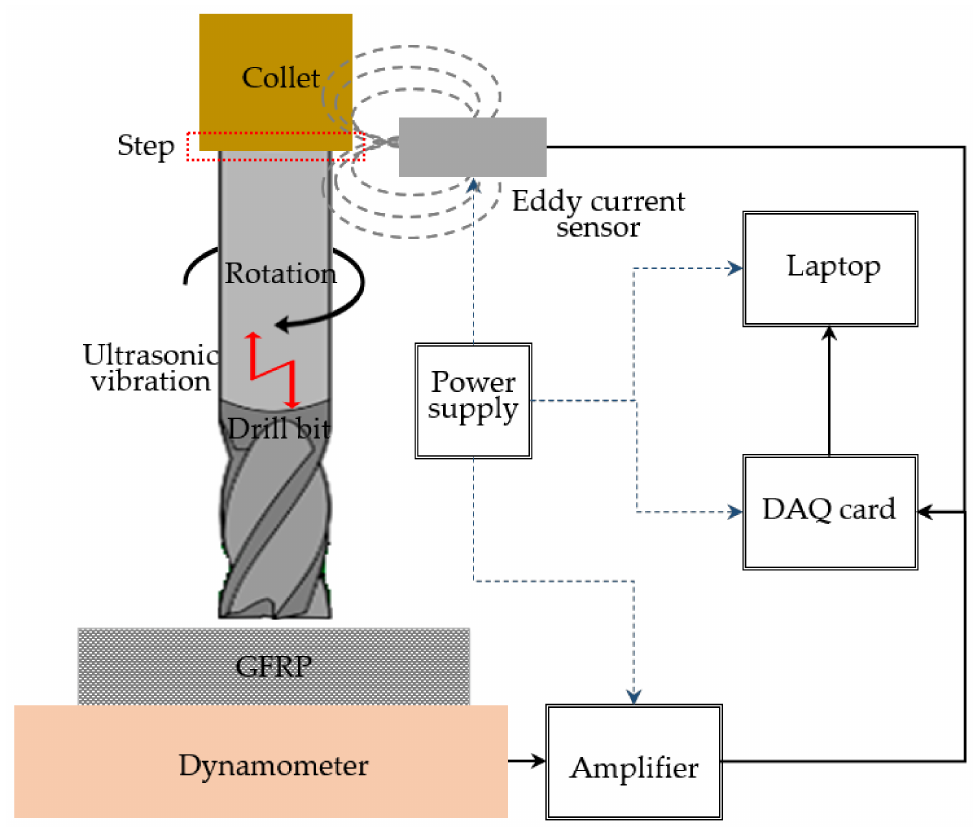
Figure 1. Schematic illustration of the experimental